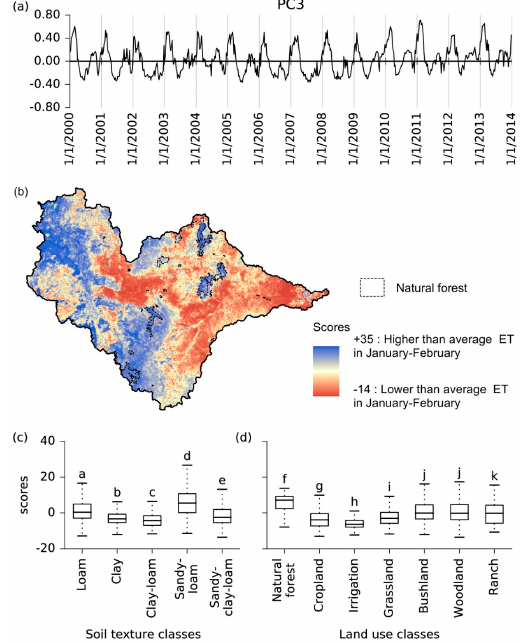
Figure 6. Time series of the loadings on the third principal component (PC3) ( a ). Map of the scores of PC3 and natural forest areas ( b ). Quartiles of the scores of PC3 for different soil texture ( c ) and land small